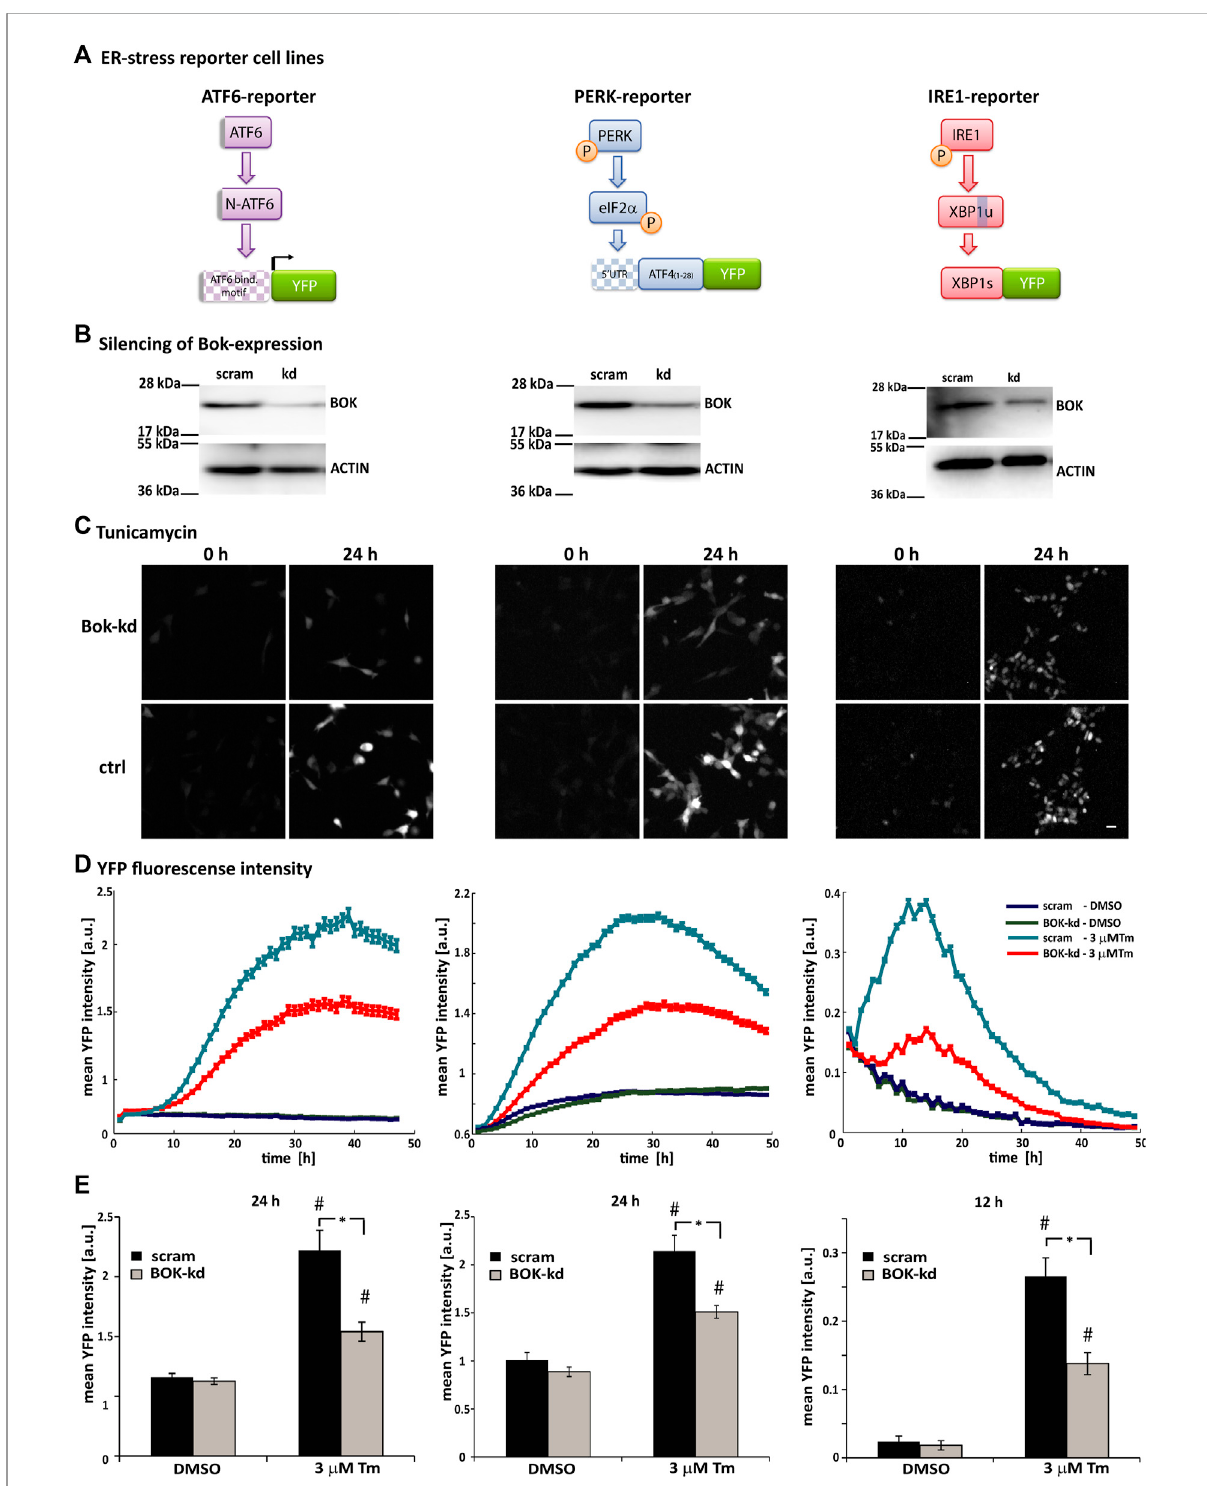
FIGURE 2 LossofBOKexpressionaffectsallthreebranchesoftheERstressresponse. (A) SchematicshowingtheprincipleoftheATF6-, PERK-, andIRE1- fl uorescent reporter constructs. Under ER stress, cleaved N-terminal ATF6 binds to the 5xATF6-binding motif and initiates transcription of the YFP reporter. PERK phosphorylates translation initiation factor eIF2 α , which initiates translation from the 5 ′ UTR of the YFP reporter. Active IRE1 α splices Xbp1 mRNA, which removes a stop codon and enables expression of the XBP1-YFP reporter fusion protein. ( B) SH-SY5Y cell lines stably